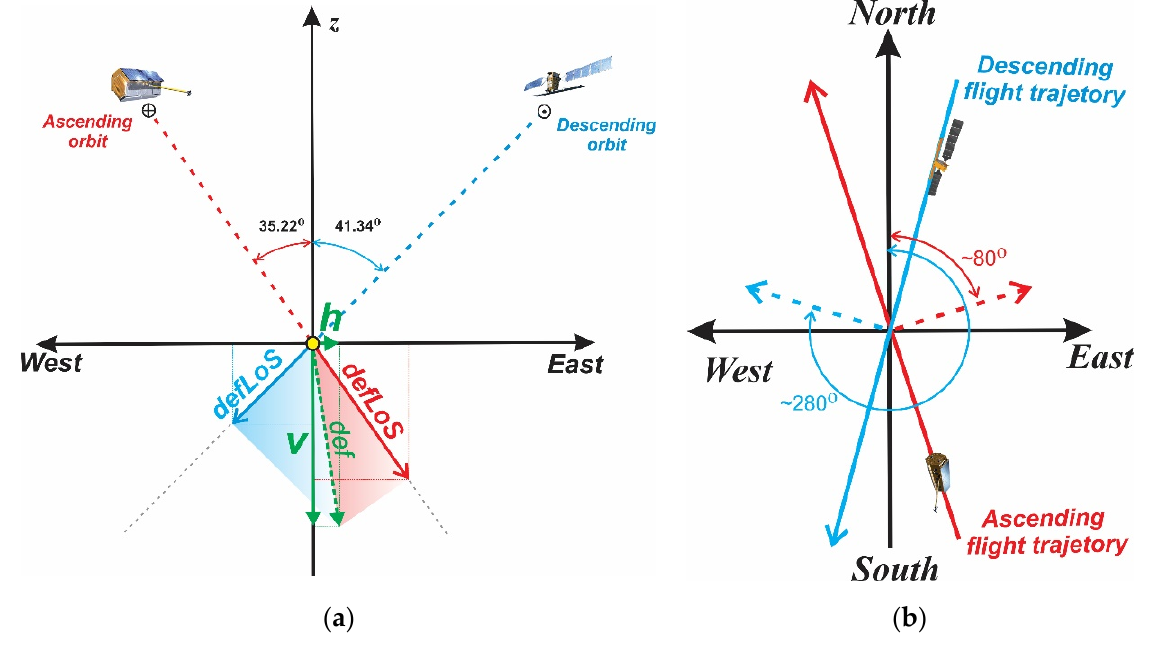
Figure 3. ( a ) Vertical and horizontal displacement obtained by 2D decomposition of the ascending and descending data (East-West direction), ( b ) imaging trajectory geometries (North-South direc- tion).